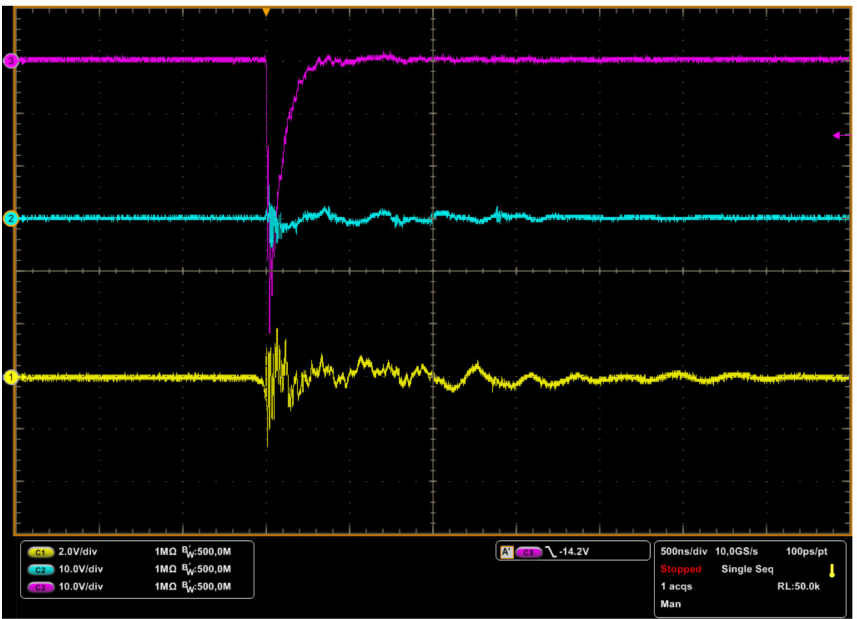
Figure 13. Oscillograms of current impulse of fourth type on the model antenna (yellow signal), discharge current from the segmented electrodes (magenta signal), and along the radome’s inner surface (cyan signal) (shunts 0.5